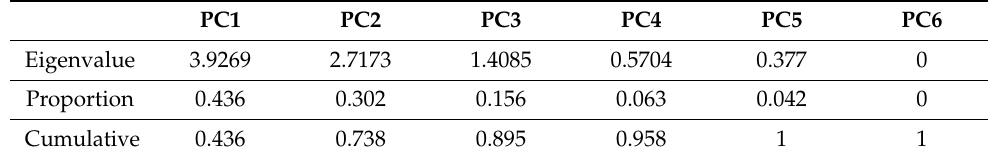
Table 10. Eigenvalues of the six remaining